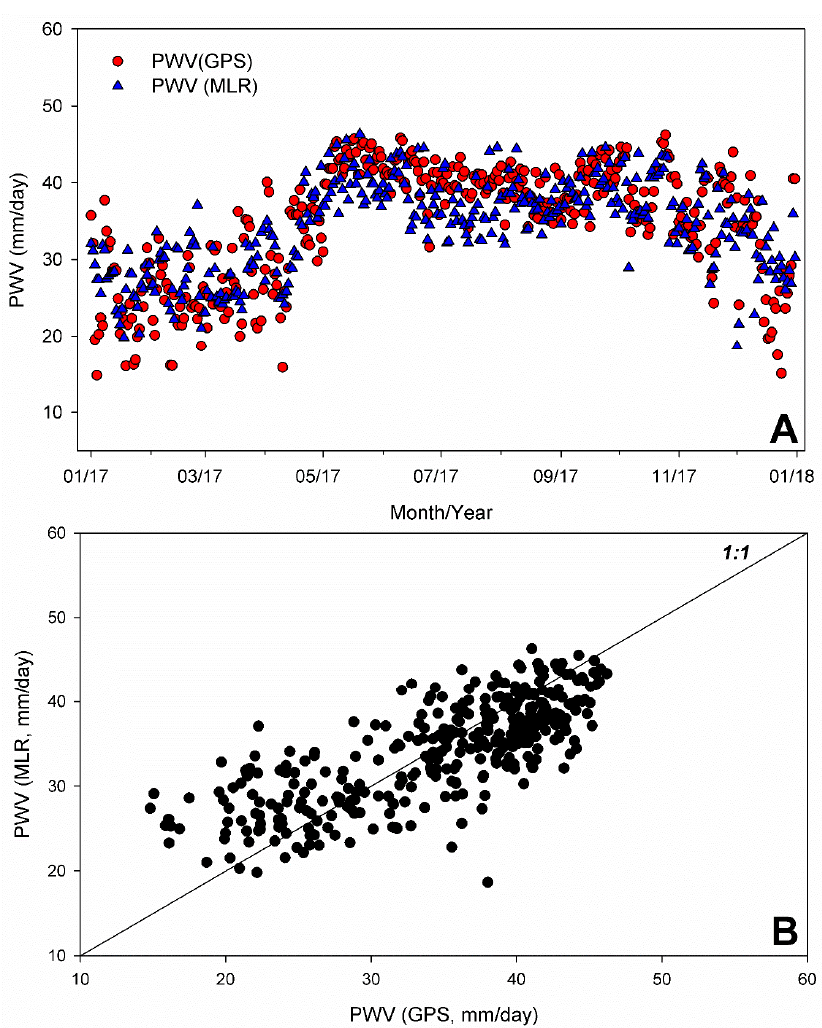
Figure 7. ( A ) The simulated PWV (mm/day) time series (blue triangles) in relation to the estimated GPS PWV (mm/day) at AACR (red circles). ( B ) The GPS PWV (mm/day) vs. simulated PWV at AACR shows the goodness-of-fit of the multiple linear regression (MLR) model.